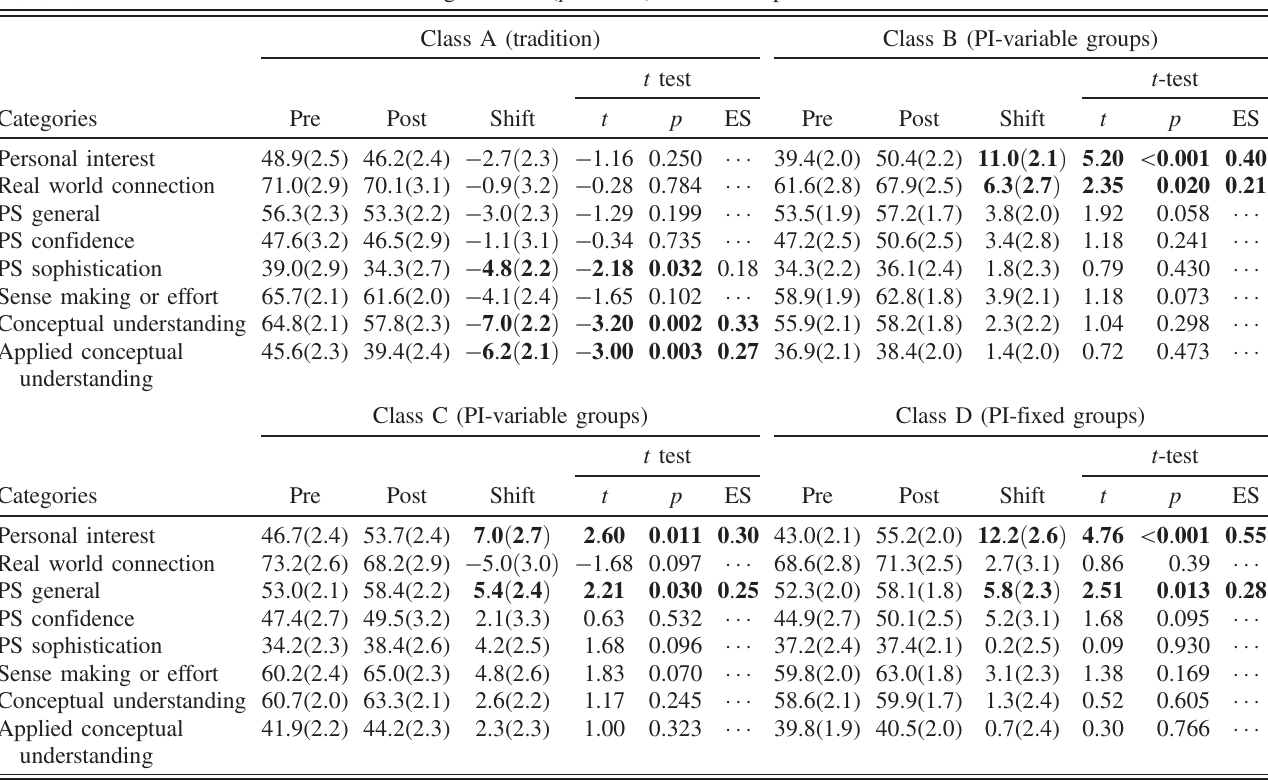
nection (in class C), though this difference was not significant [ t ð 94 Þ ¼ − 1 . 68 , p ¼ 0 . 097 ].